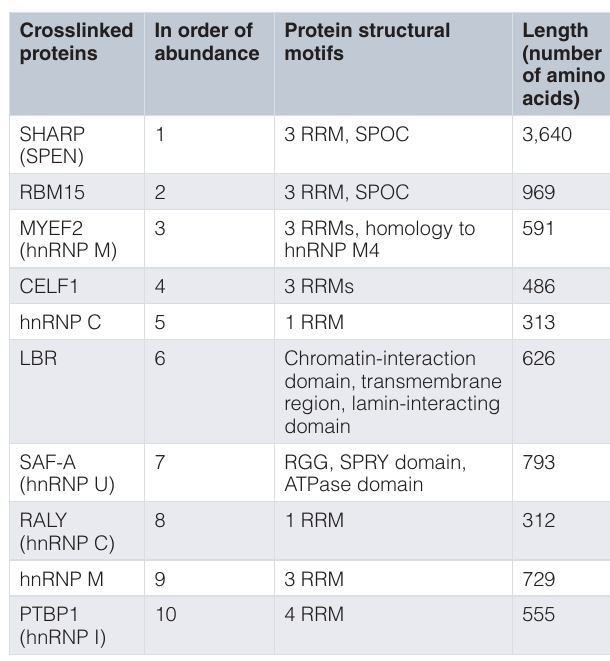
Table 2. Mouse embryonic stem cells: top 10 Xist-binding proteins from RAP-MS 23 . Crosslinked In order of Protein structural proteins abundance motifs